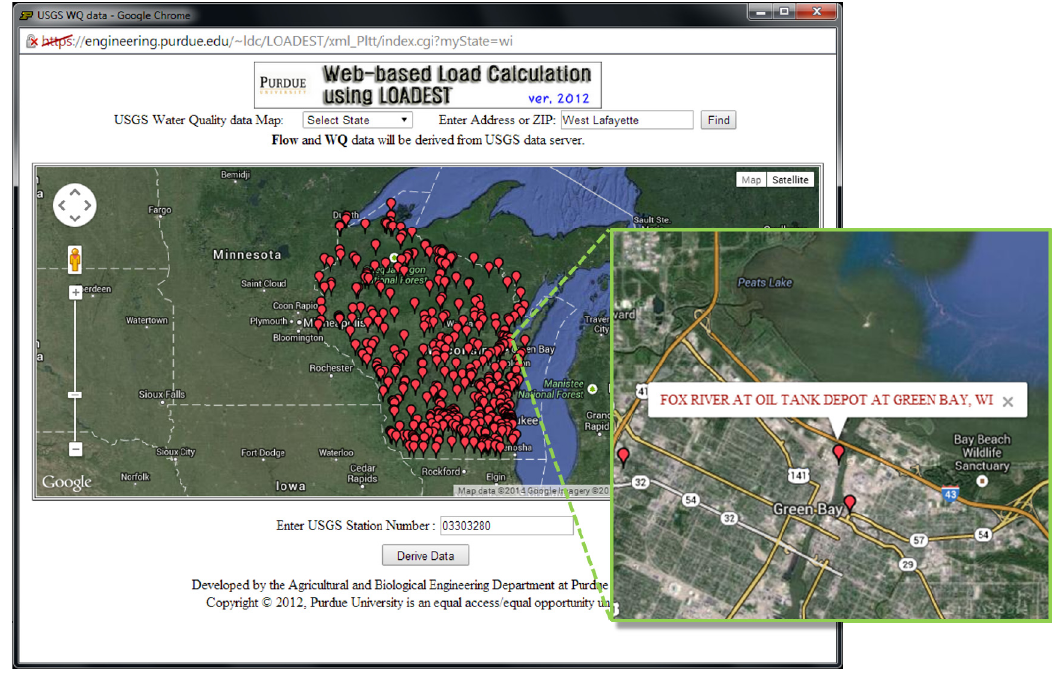
Figure 4. Location of USGS station named Fox River at Oil Tank Depot at Green